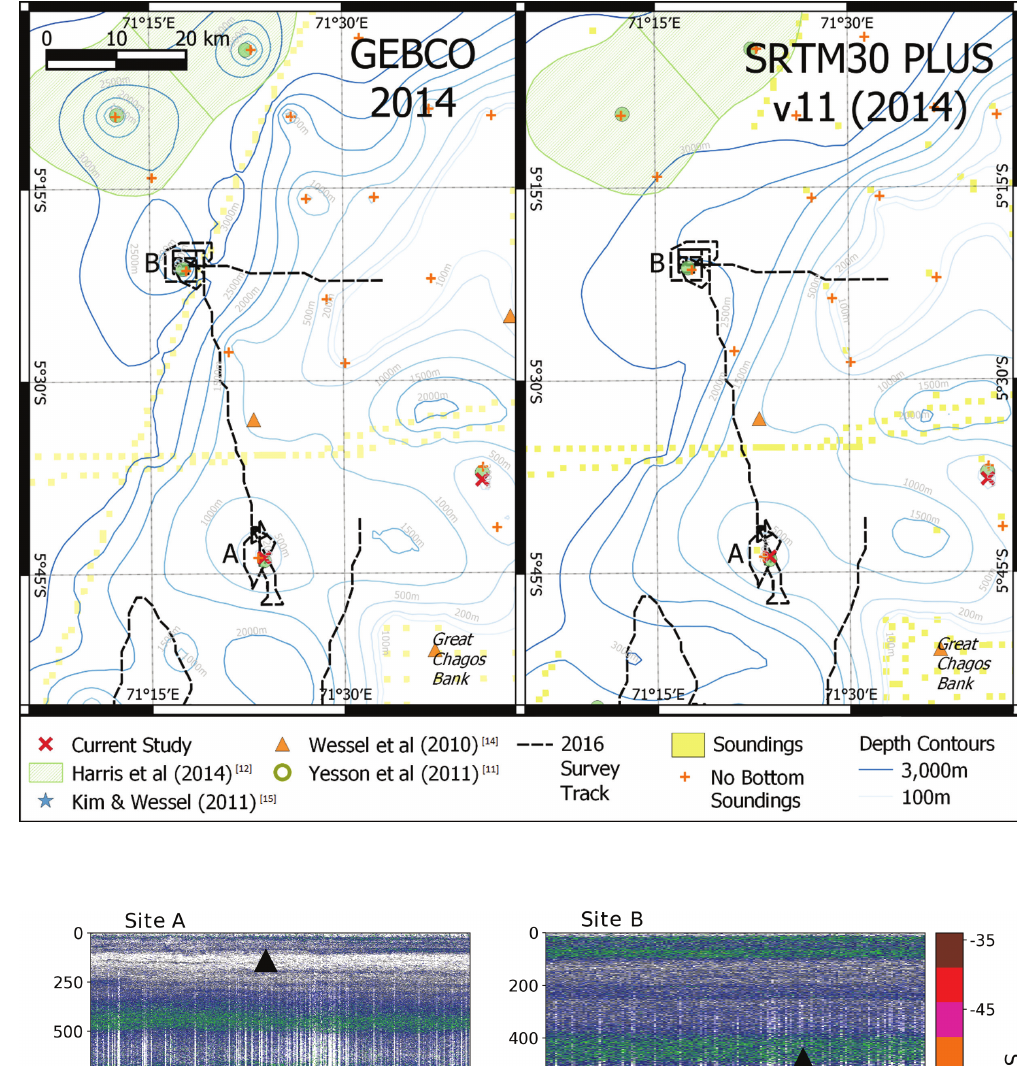
Latitudinal transects across apparent positions of the two ‘phantom seamounts’. Black triangles are overlayed at the position and summit depth of the predicted seamounts. Colormap is volume backscattering strength (Sv). A deep scattering layer was observed at c.450 m for both sites. Seabed was observed at site A c.1500 m (red line). No seabed was detected for site B (i.e., seabed is deeper than the limit of the